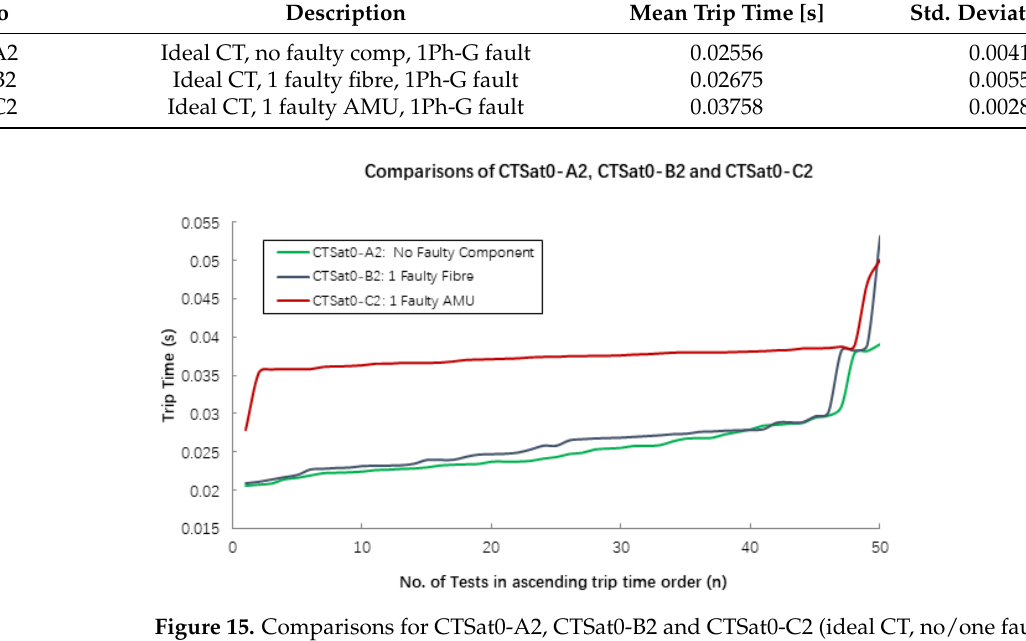
Table 5. All trip times are sorted from the fastest to the slowest in ascending order, as listed in Figure 15. Table 5. Trip times for single-phase-to-ground fault.